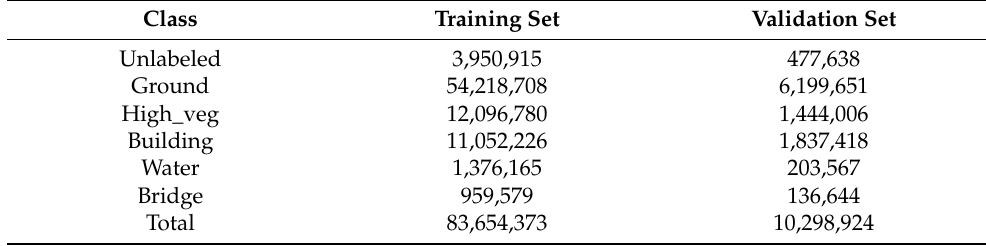
Table 3. The number of points and detailed category distribution of the DFC 3D dataset. High_veg represents high